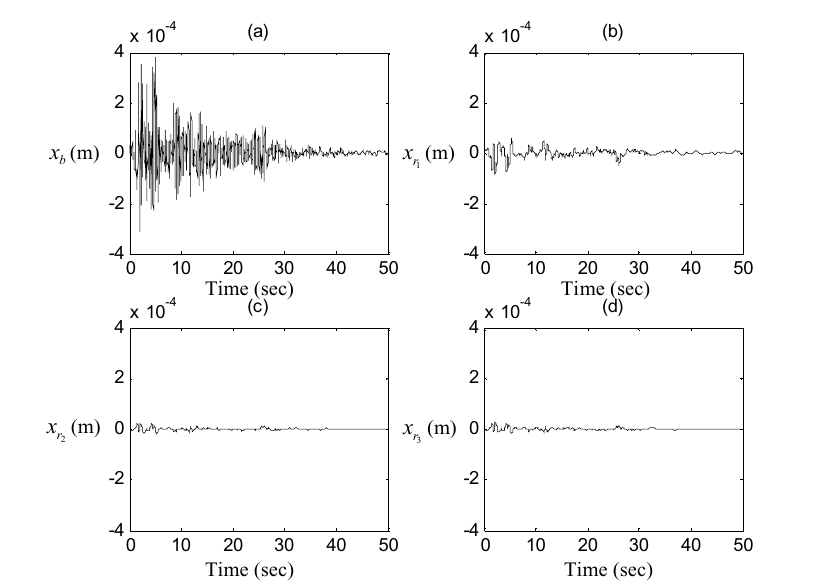
Fig. 6. Relative displacement of passive controlled structure by confinement with the FMA approach. (a) Passive element x r 1 = x p ; (b) First mass x r 2 = x 1 ; (c) Second mass x r 3 = x 2 − x 1 ; (d) Third mass x r 4 = x 3 − x 2